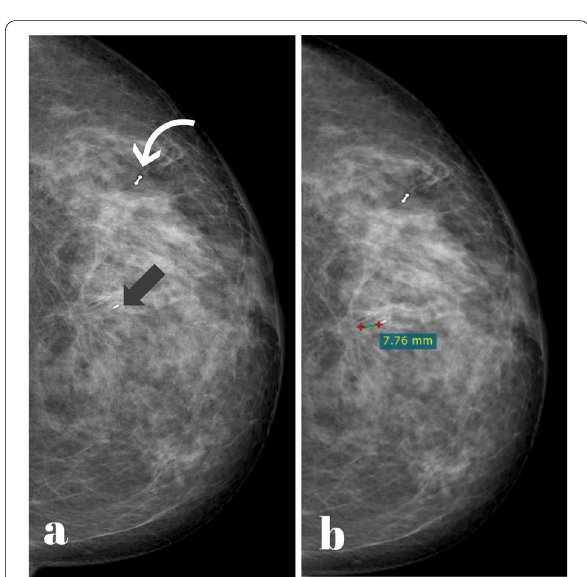
Fig. 7 Forty‑five years old lady had a bicentric breast masses with initially diagnosed unifocal mass. a A dumbbell shape commercial clip [curved arrow] outside the institution. A second focus was identified and a surgical clip was applied [straight arrow]. b the clip is applied 7mm from the second focus